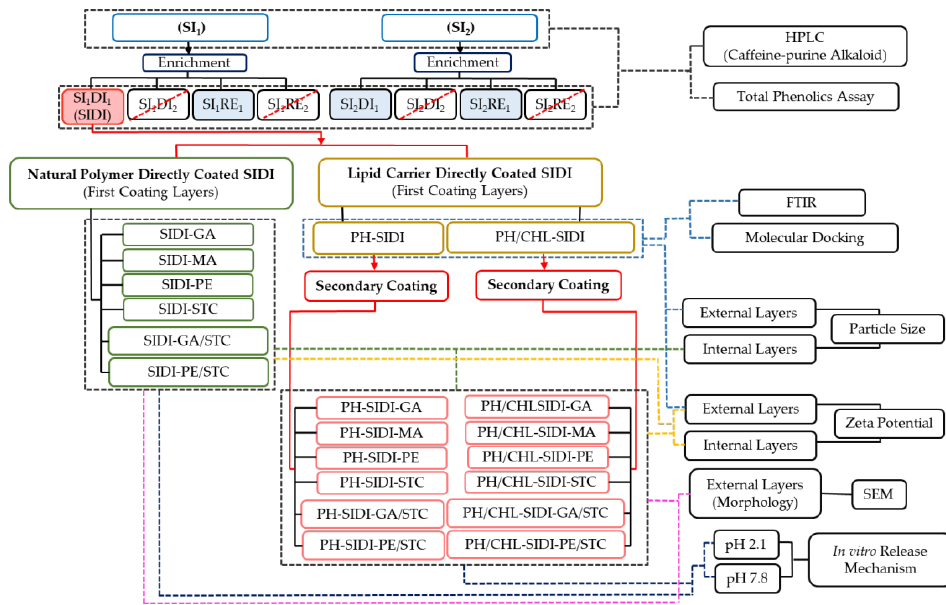
Chart 2. Sample categorization and analyses applied to each category. SI, silverskin; GA, gum Arabic; MA, maltodextrin; PE, pectin; STC, starch; PH, nano-phytosome; PH/CHL, cholesterol incorporated nano-phytosome. DI 1 and RE 1 series are the enriched fractions (regarding caffeine and phenolics contents) obtained with Diaion TM HP20LX (DI) and Relite EXA90 (RE) adsorbent resins,